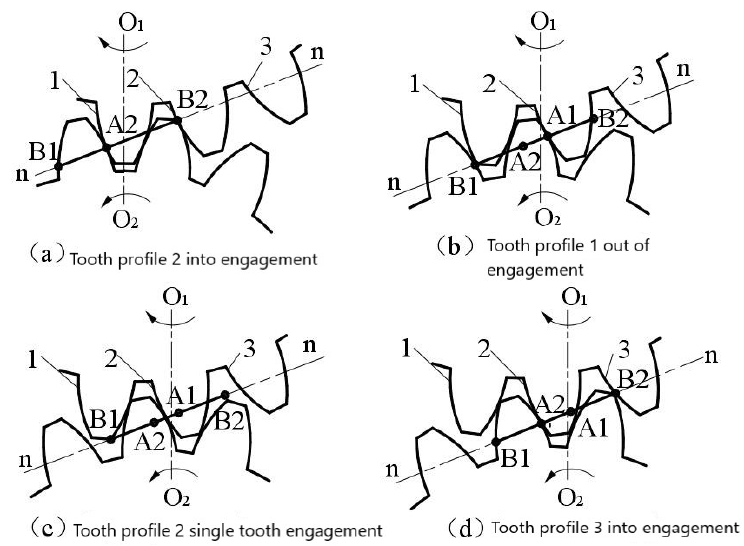
Figure 21. Pinion gear meshing process with large gear